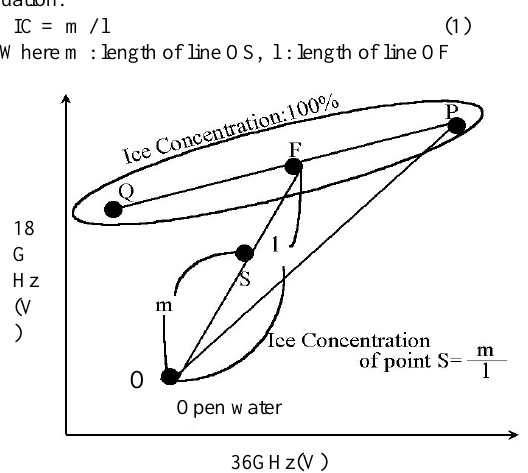
Figure 2. Schematic diagram of calculating ice concentration in the AMSR Bootstrap